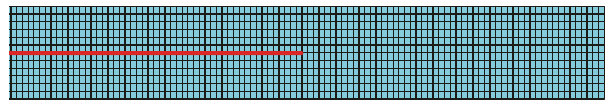
Figure 3: Interface mesh of the crack tip area in 4-ENF